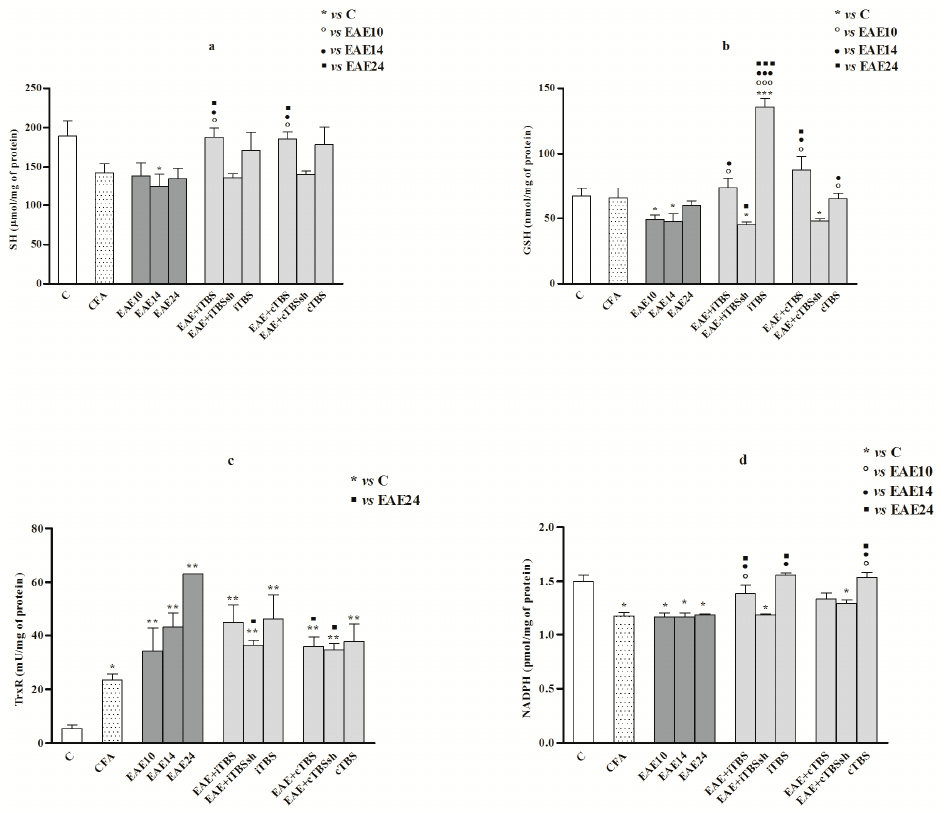
Figure 4. ( a – d ). Thiol-associated biochemistry and NADPH status in the rat spinal cord. Parameters of thiol species-associated biochemistry in the spinal cord at 10, 14 and 24 dpi in EAE rats, and after iTBS/cTBS: ( a ) total sulfhydryl groups (SH; μ mol/mg proteins); ( b ) Glutathione (GSH; nmol/mg proteins); ( c ) Thioredoxin reductase (TrxRs, mU/mg proteins); ( d ) Nicotinamide adenine